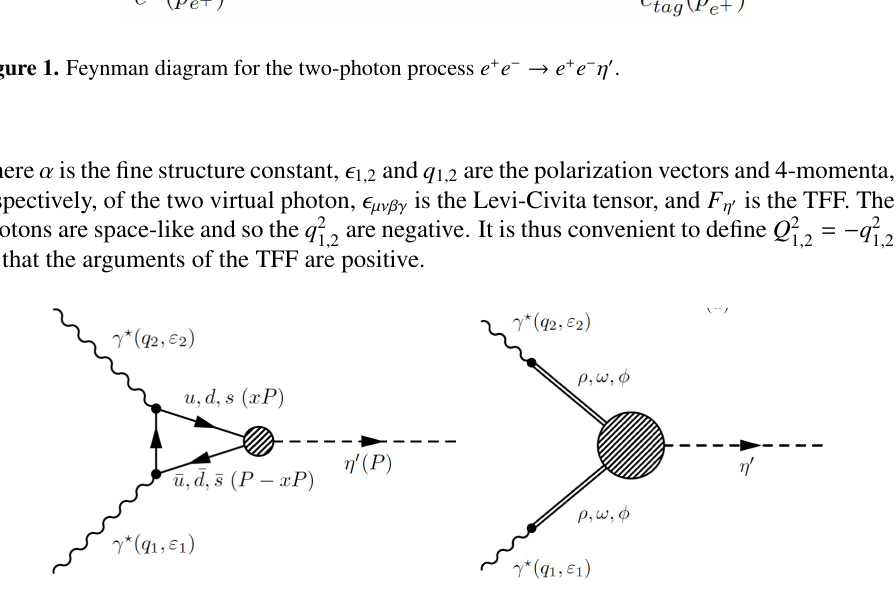
Figure 2. Diagrams illustrating the (left) perturbative QCD and (right) vector meson dominance model descriptions of the γ ∗ γ ∗ → η (cid:48)